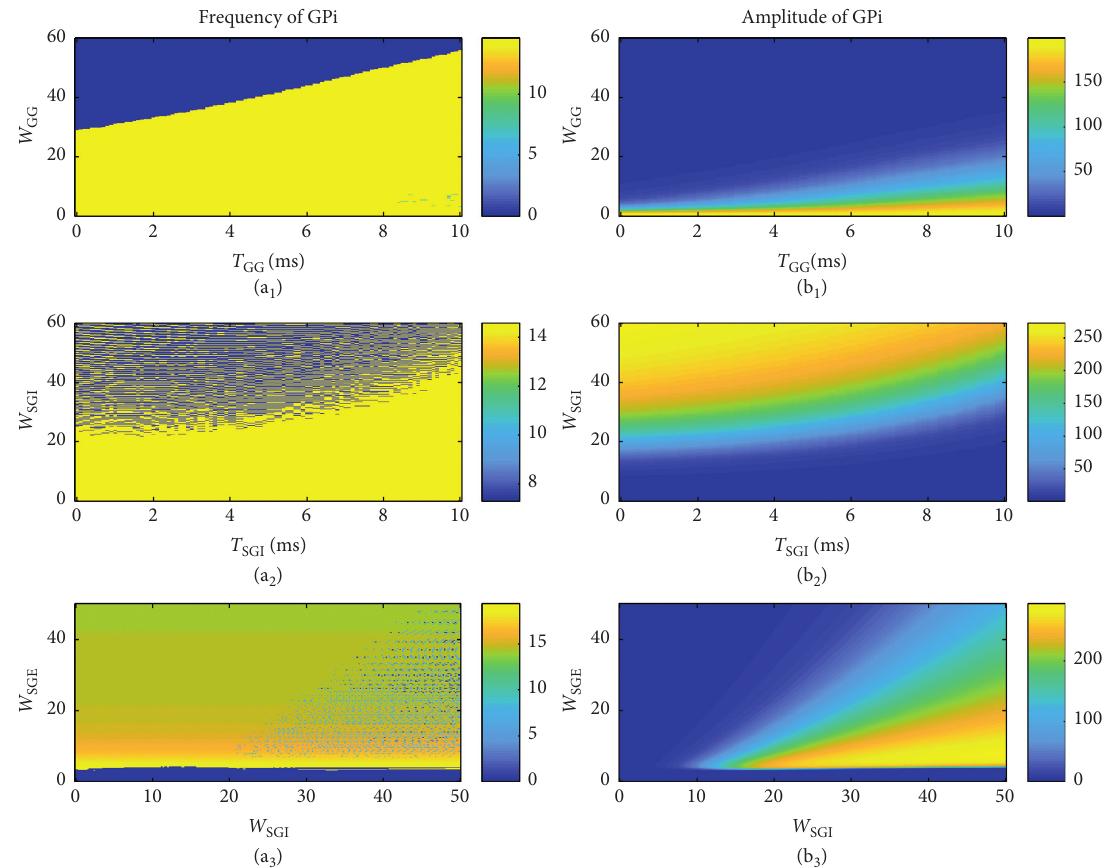
− T − T − W , W , and W on the frequency of the GPi firing rate (a 1 )–(a 3 ) and the amplitude of GPi GG GG SGI SGI SGE SGI